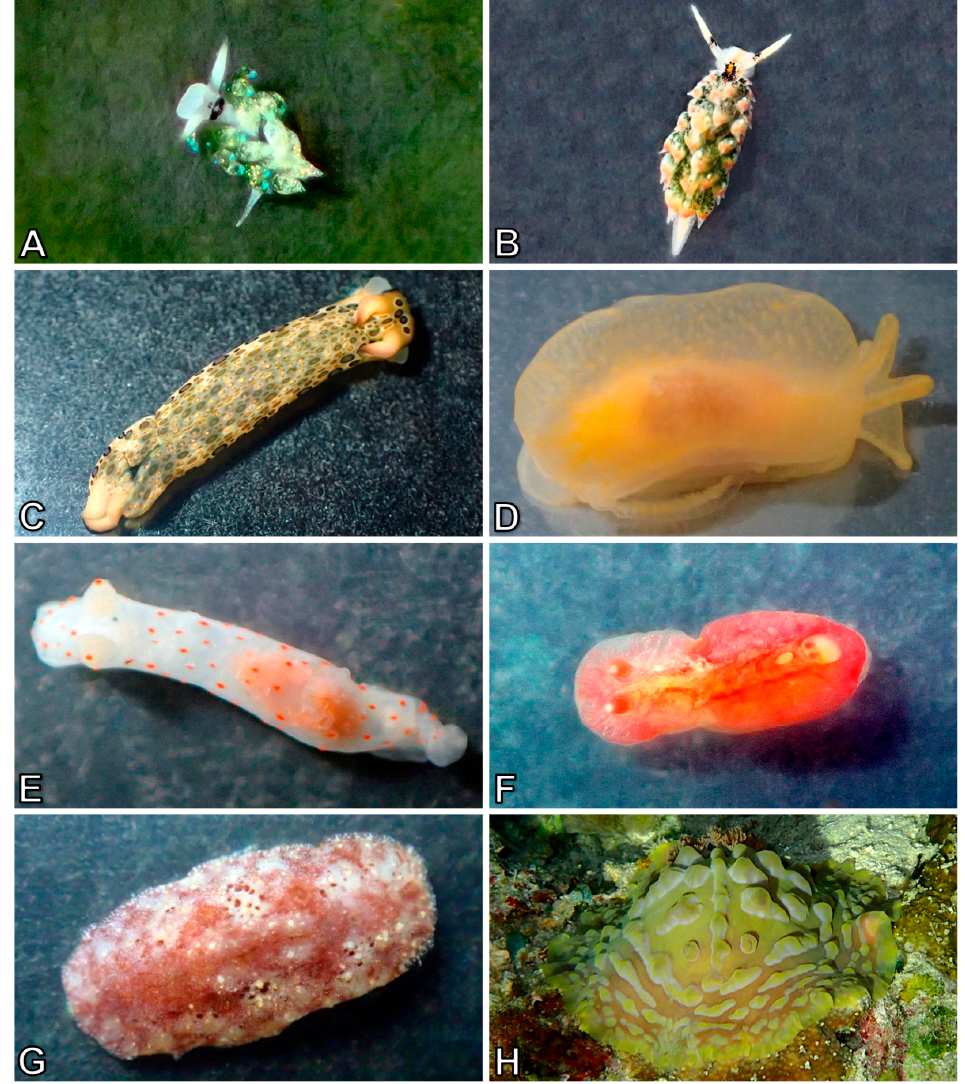
Figure 18. Sacoglossa, Pleurobranchomorpha and Nudibranchia - Doridina: ( A ) Costasiella spec. ( Costasiella